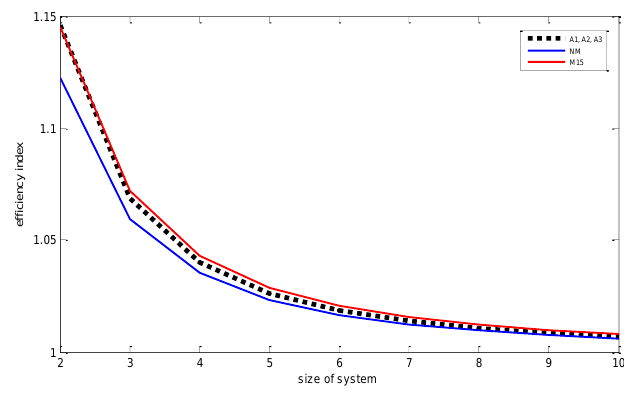
Fig. 1. Efficiency index comparison for different